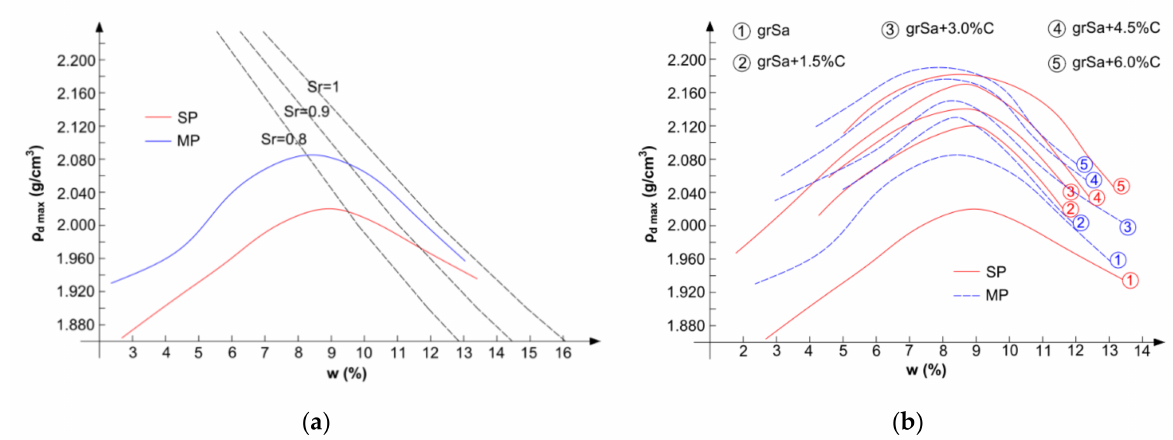
Figure 4. Compaction curves obtained by the standard Proctor (SP) and modified Proctor methods: ( a ) gravelly sand and ( b ) gravelly sand and its mixtures with cement addition (C).